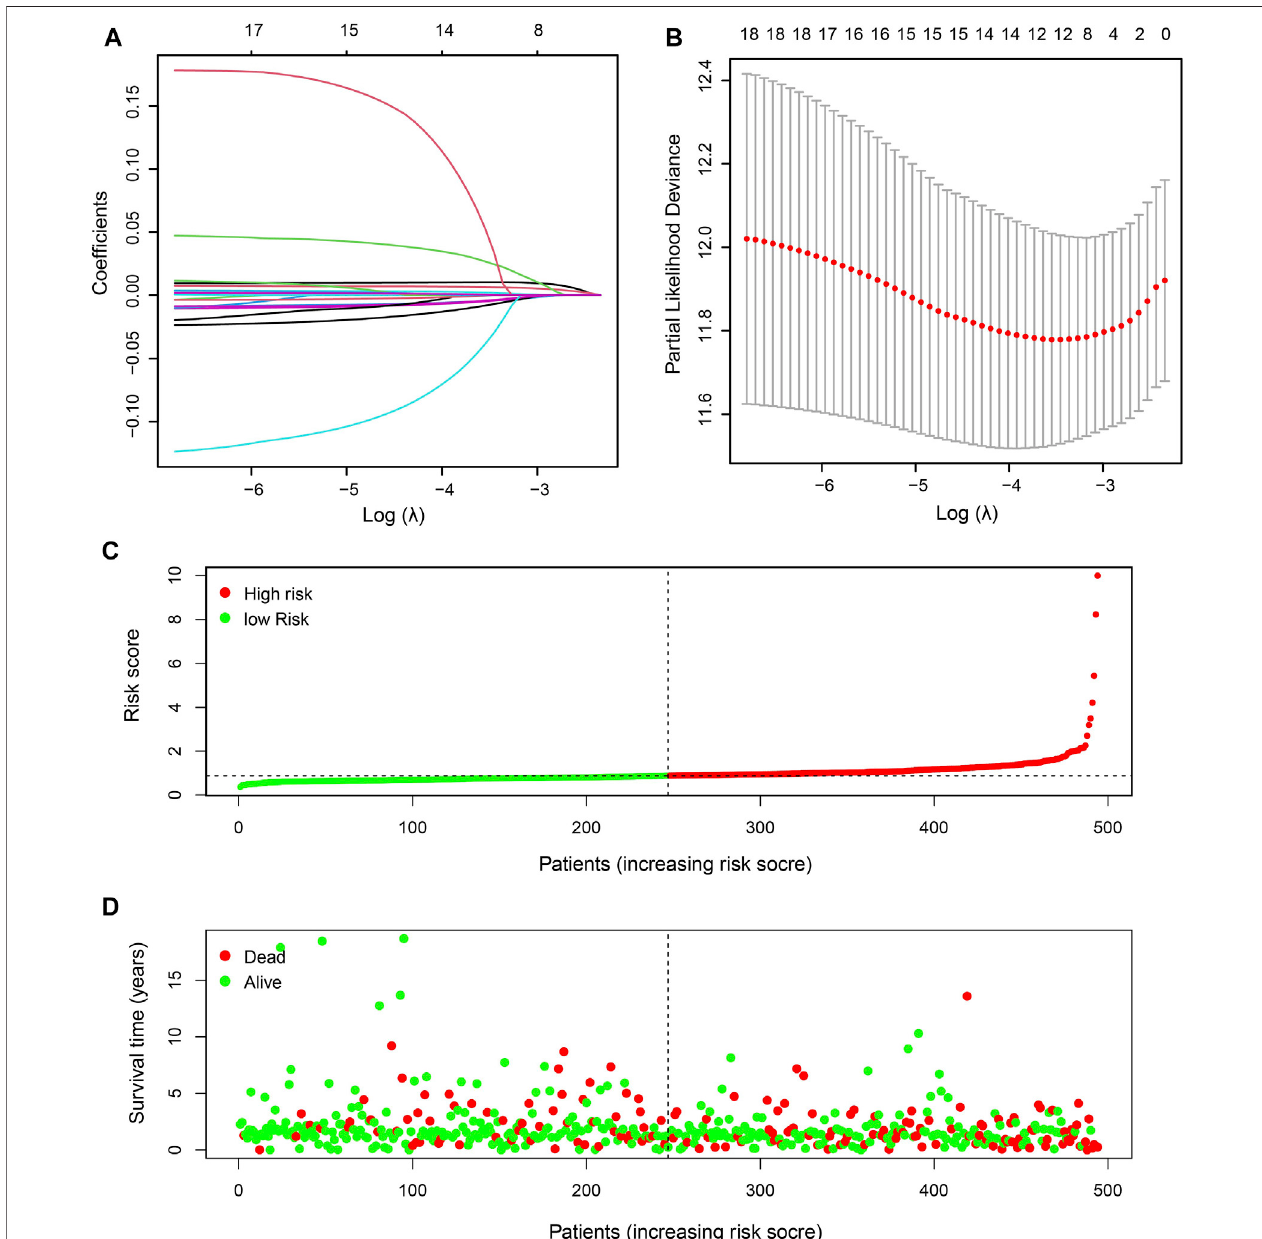
FIGURE 1 | Identi fi cation of prognostic ETC-associated genes. (A) . The LASSO coef fi cient distribution map of the 12 ETC genes in LUAD patients. (B) . The partial likelihood deviance plot based on the LASSO model. (C) . The risk score distribution of the 12-gene risk signature model in LUAD patients. (D) . The survival status of patients in high-risk and low-risk groups of LUAD